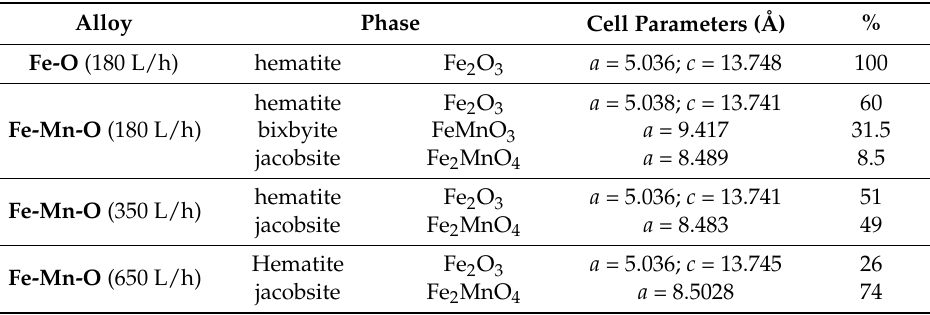
Table 3. Phase percentage and cell parameters ( a and c ) of the obtained foams.